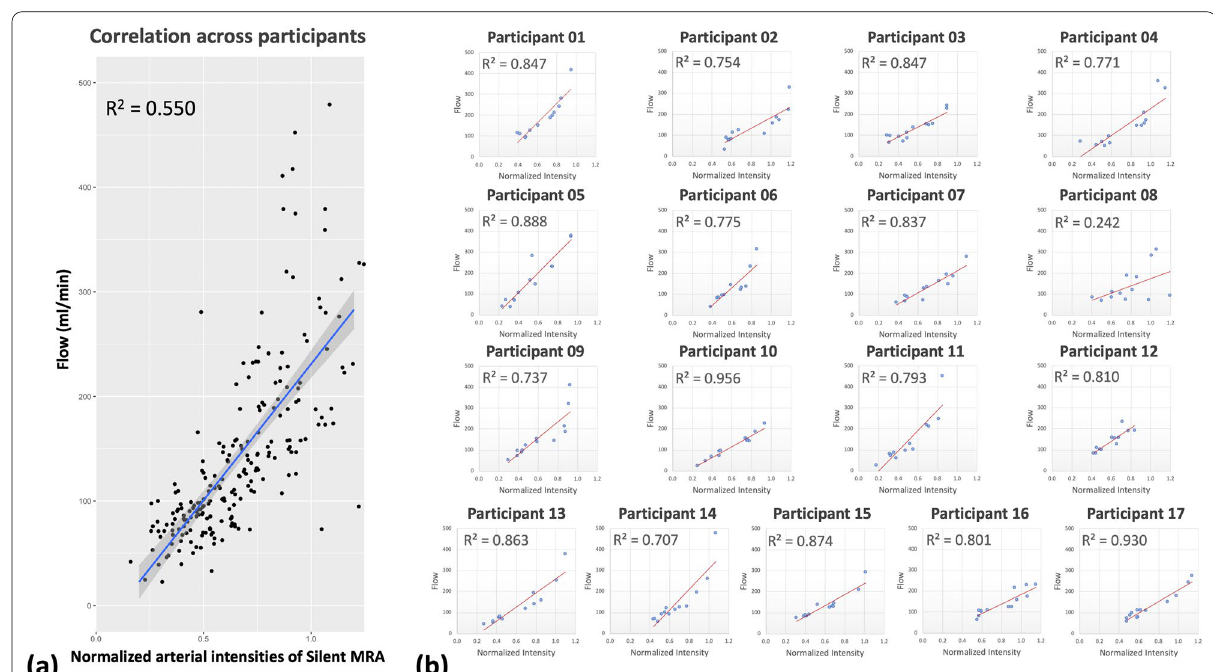
Fig. 4 Linear correlations between the normalized arterial intensities in Silent MRA and CBF determined using 2D PC‑MRA. a Correlation between the normalized arterial intensities and the corresponding CBFs was highly linear ( R 2 0.550). The dark grey area indicates the 95% confidence = interval of the linearly fitted line. b At the individual participant level, normalized arterial intensity was also highly linearly